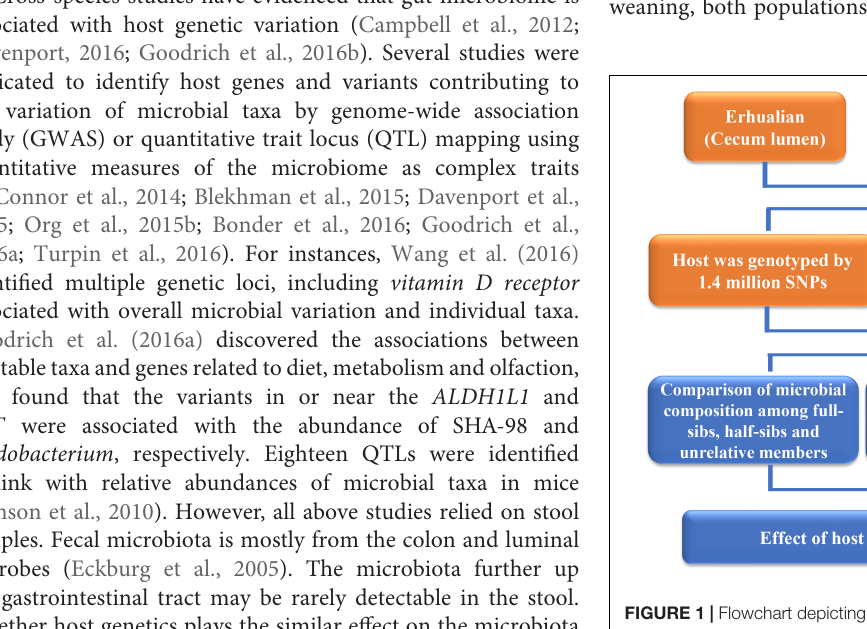
Frontiers in Microbiology |